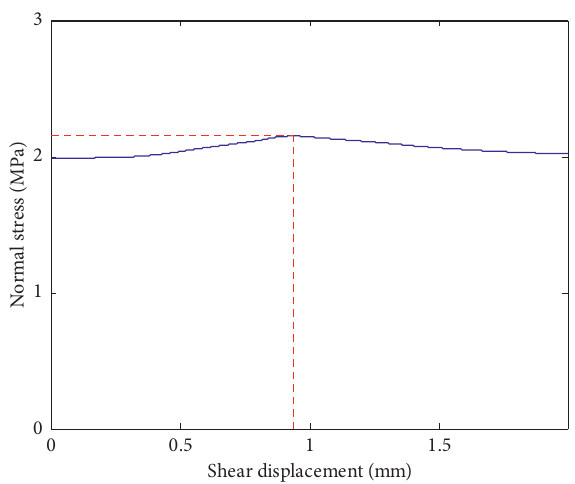
Figure 7: Variation of the normal stress of the shear failure plane.